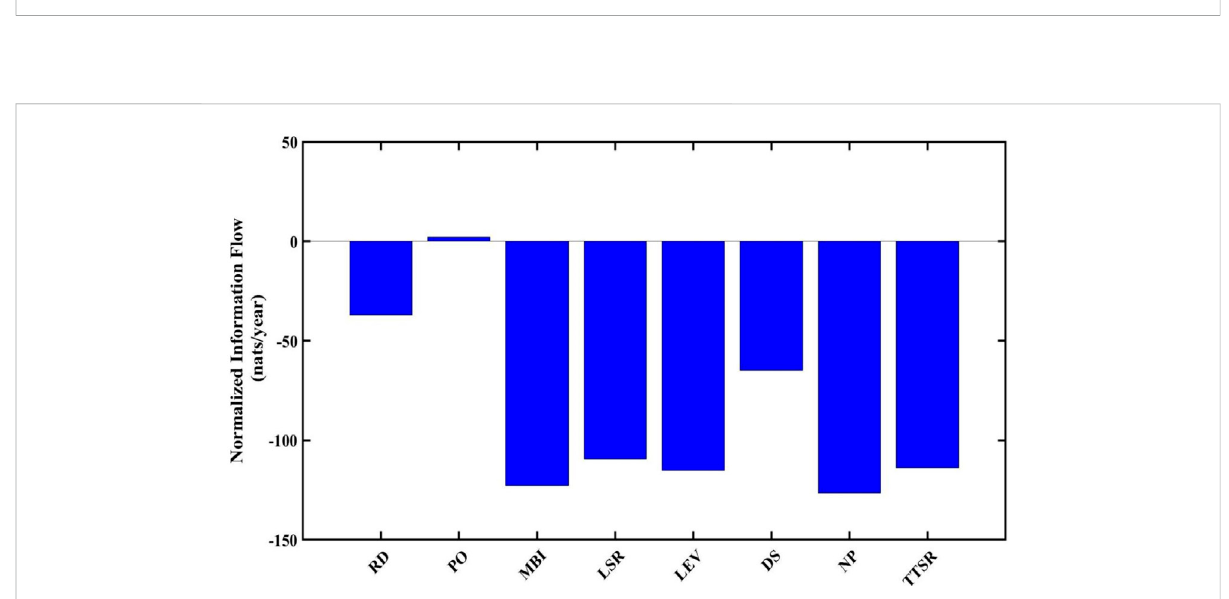
FIGURE 2 Relative importance of detected causality from each variable to